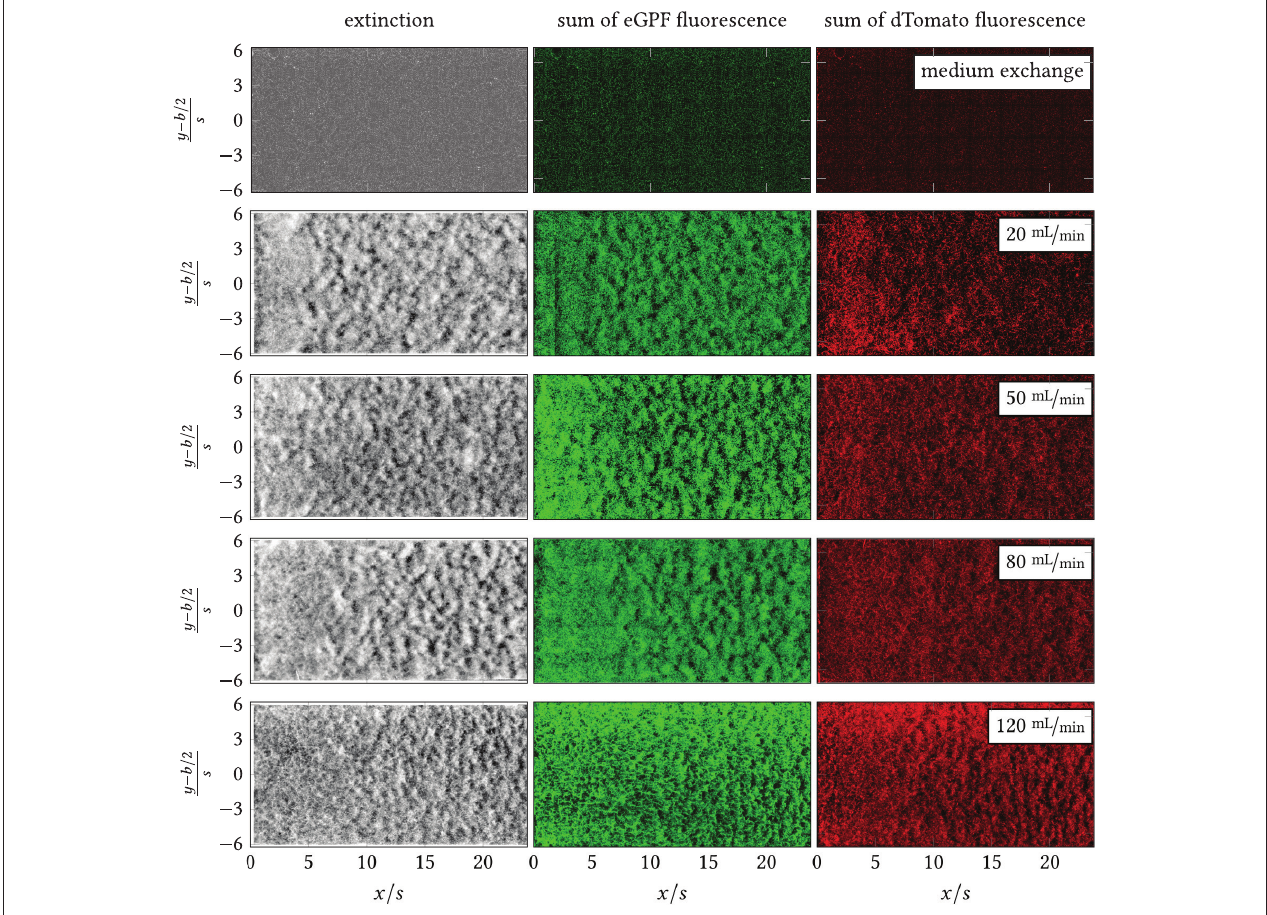
FIGURE 8 | Overview images of extinction, sum of eGFP fluorescence and dTomato fluorescence downstream of the step (left image margin, x / s = 0) for the blank sample (exchange of minimal medium on minimal shear) and ˙ V = { 20,50,80,120 } mL min − 1 . All pictured distributions were measured at the last time point per experiment, i.e., t end = { 26.13,23.48,22.50,24.10,22.42 } h. Black line: time-averaged reattachment line x r ( x , y ) per ˙ V . The color space of each image has been adjusted for the highest possible contrast. Intensity-based differences between images are, thus, not equivalent to quantitative